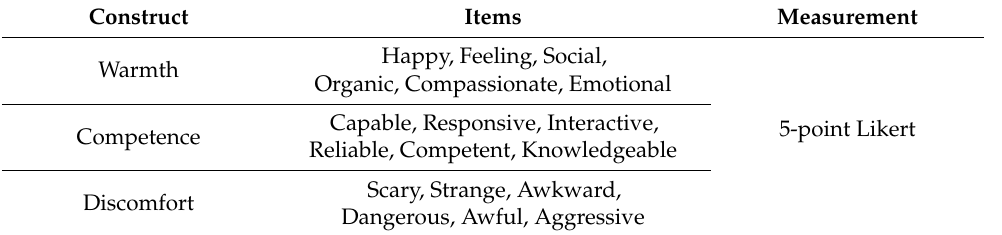
Table 3. Items of the RoSAS.